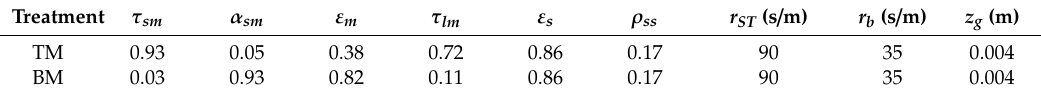
Table 3. The model parameters (shortwave transmittance τ sm , shortwave absorptance α sm , emissivity ε τ m , and longwave transmittance lm of the plastic film mulch; emissivity ρ ss of soil; mean stomatal resistance r ST , mean boundary layer resistance r b ; and distance between the